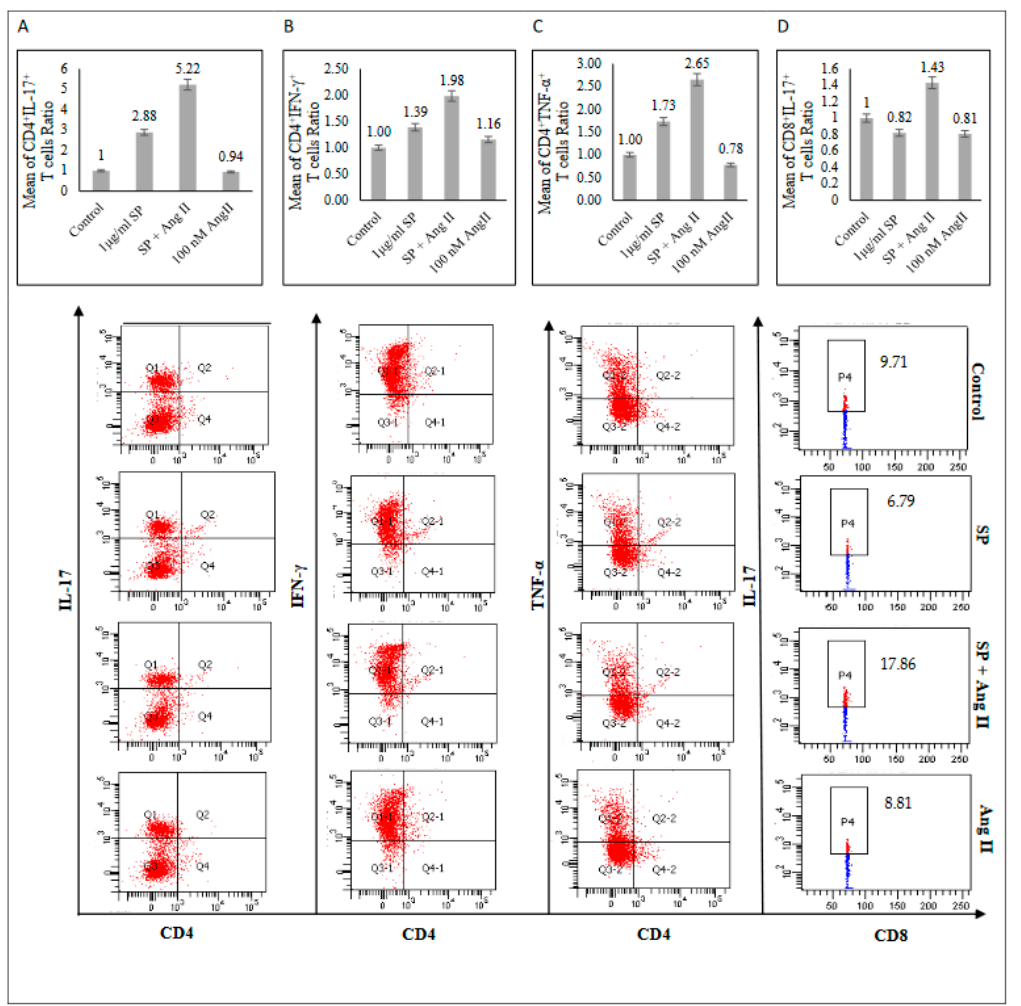
Figure 5. Functional profile of T-cells from recovered COVID-19 patients (n = 5) after mitogenic stimulation. ( A ) Upper: CD4+ IL-17+. Lower: FACS representative plot. ( B ) Upper: CD4+ IFN- γ +. Lower: FACS representative plot. ( C ) Upper: CD4+ TNF- α +. Lower: FACS representative plot. ( D ) Upper: CD8+ IL-17+. Lower: FACS representative plot. The mean of the T-cells ratios was measured as the percentage of T-cells producing cytokine in each group to the percentage of T-cells producing cytokine in the control group.